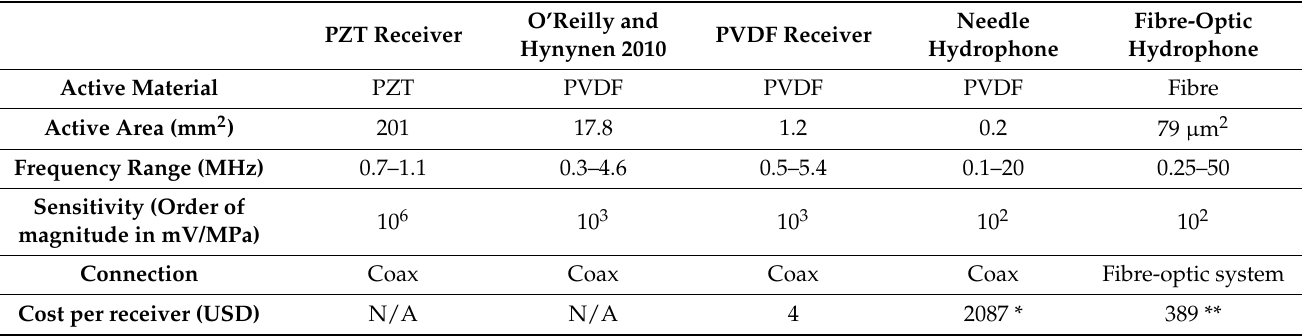
Table 1. Receivers of different designs.